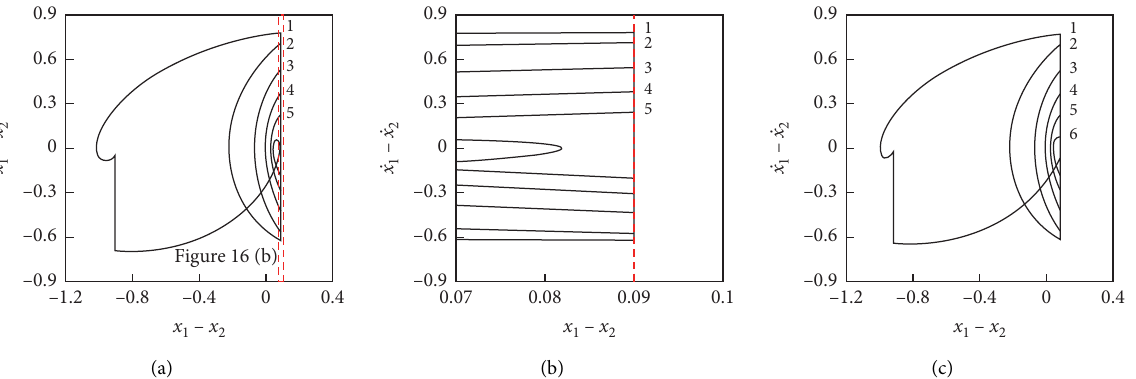
Figure 16: Phase diagram of 5/1 motion and 6/1 motion with different initial values coexisting in the hysteresis domain HR and ω � 0 . 4853. (a) 5/1 motion; (b) local enlargement of Figure 16(a); (c) 6/1 motion.